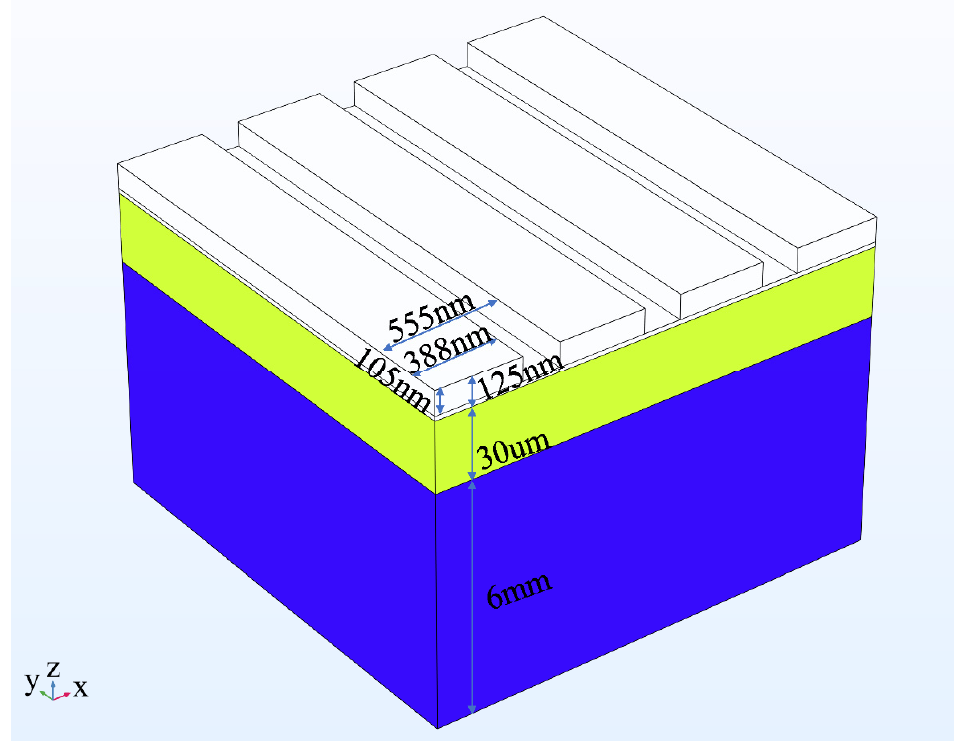
Figure 1. Schematic diagram of the grating structure.